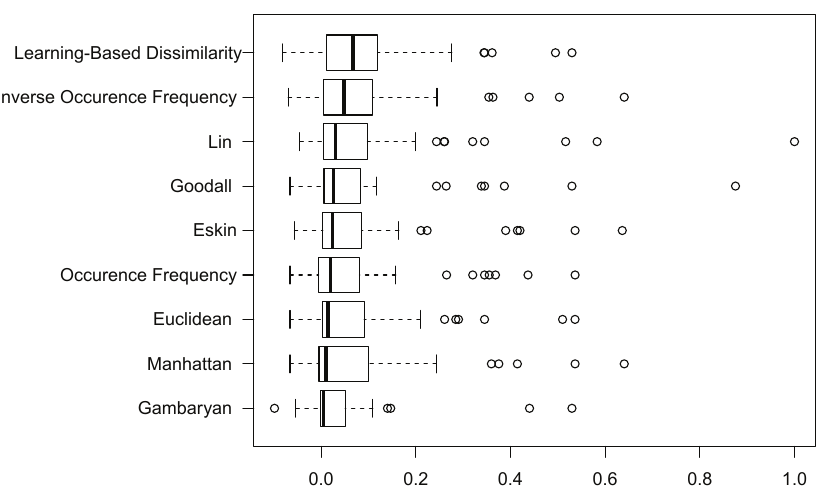
Figure 3. Box and whisker diagram according to Adjusted Rand Index [17], for KMeans++ [15] using all the dissimilarity measures, considering all the tested datasets. The results are sorted from top to bottom in descending order of the median.